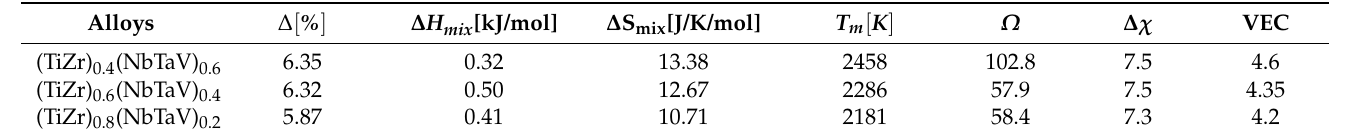
Table 3. The atomic radius ( δ ) , enthalpy of mixing ( ∆ H mix ) , entropy of mixing ( ∆ S mix ) , melting temperature ( T m ) , Ω parameter, electronegativity difference ( ∆ χ ), and valence electron concentration